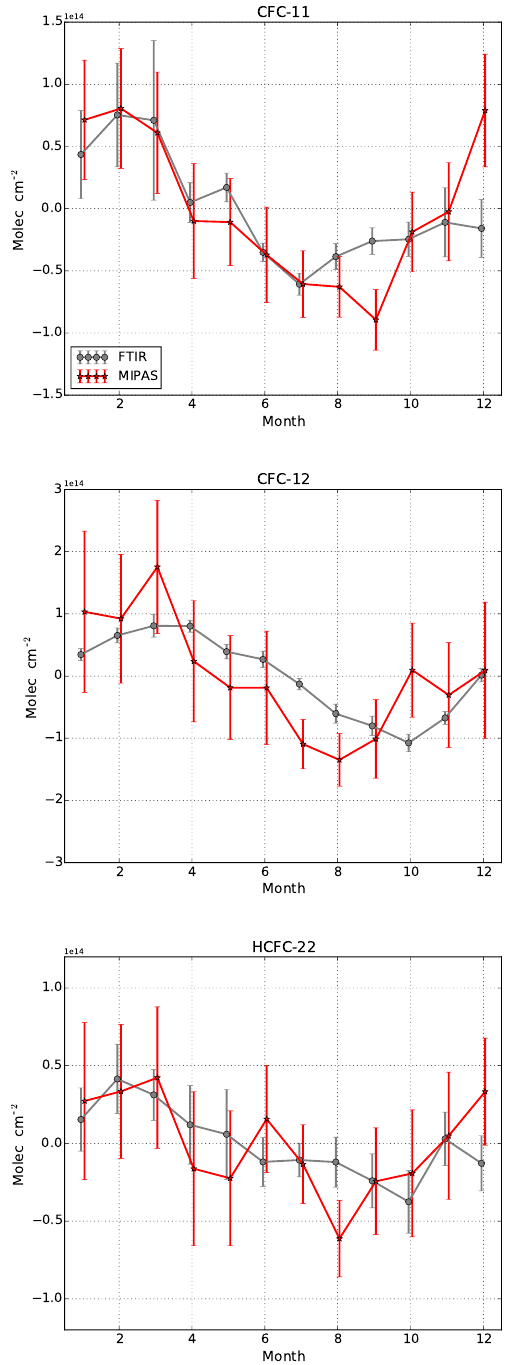
Figure 8. Seasonal cycles of CFC-11, CFC-12 and HCFC-22 based on FTIR measurements (grey) and MIPAS data (red). The mean of the measurements for each month during the 2004–2016 period for FTIR measurements and 2004–2011 for MIPAS data, after subtrac- tion of the trend, is shown as circle (FTIR) and asterisk (MIPAS), √ n ; n being the number together with the 2 σ error on the mean (2 σ/ of measurements for each